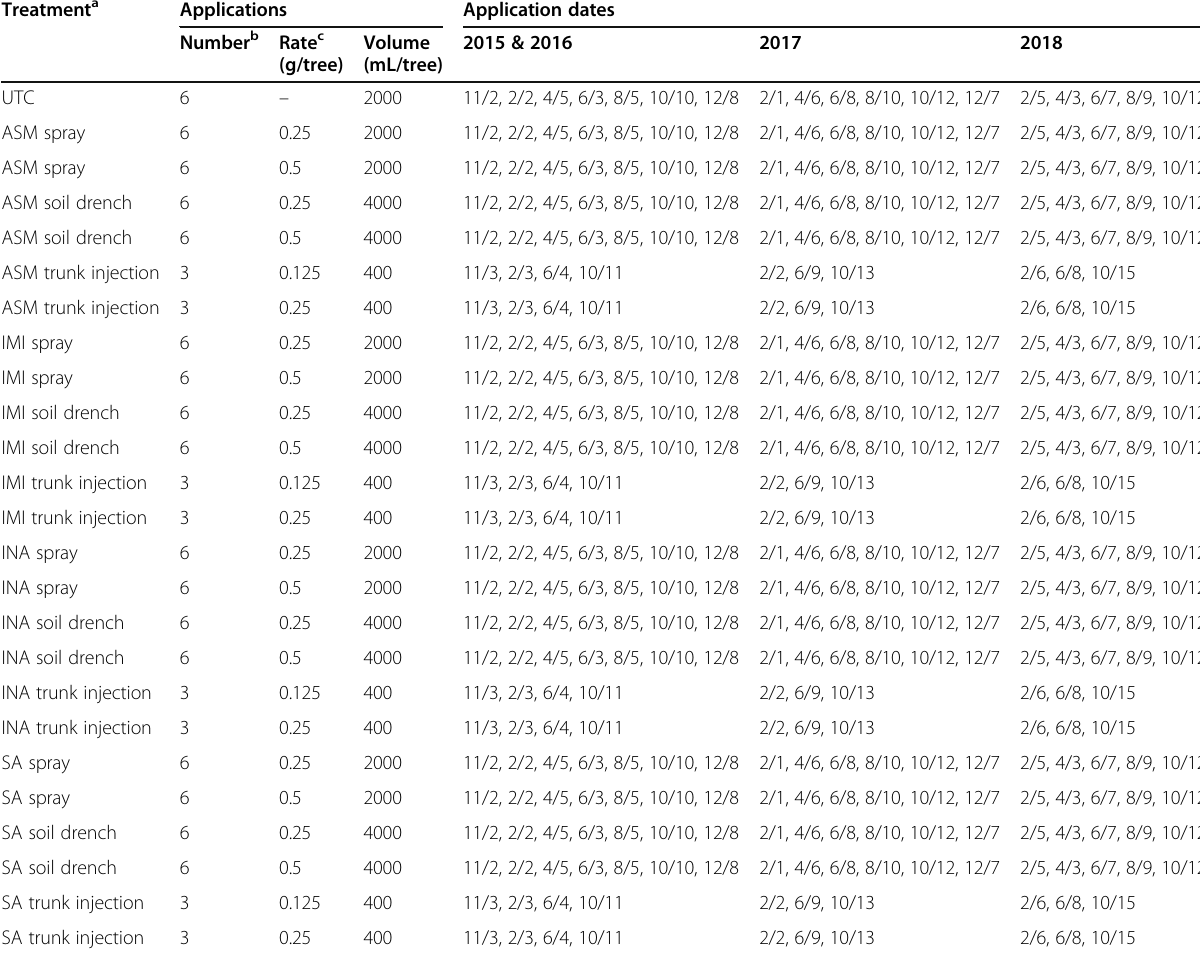
Table 6 Treatments applied to Hamlin sweet orange trees in a three-year field trial (2015 – 2018) at CREC-Lake Alfred, FL Treatment